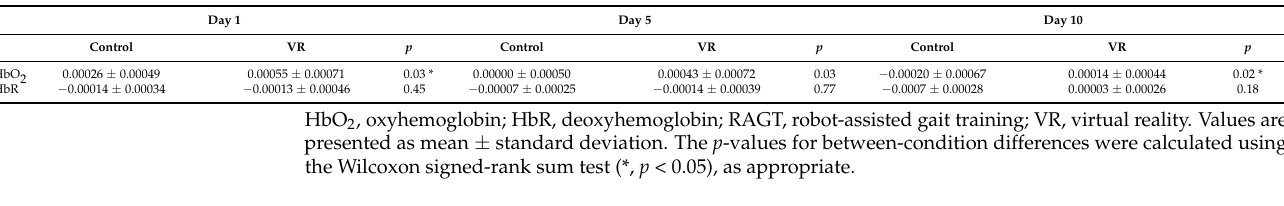
Table 3. Comparison of HbO 2 and HbR between RAGT with VR and RAGT without